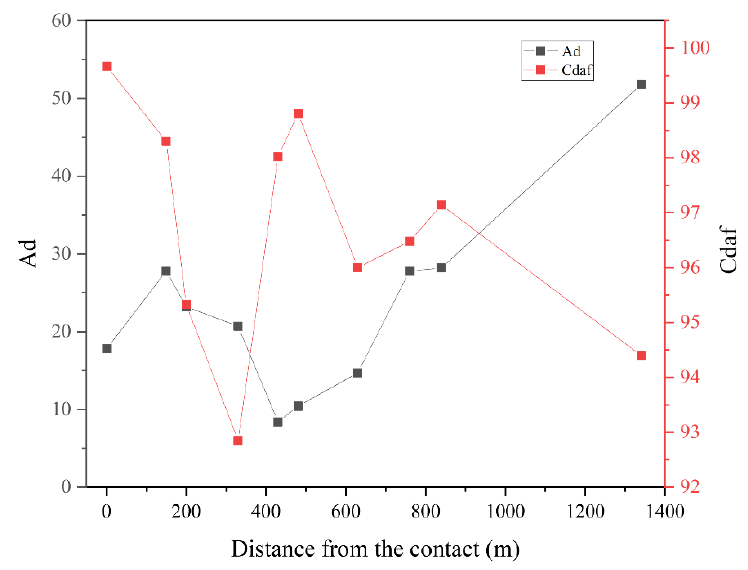
Figure 2. Contents of Ad and Cdaf versus distance from the intrusive contact horizon.